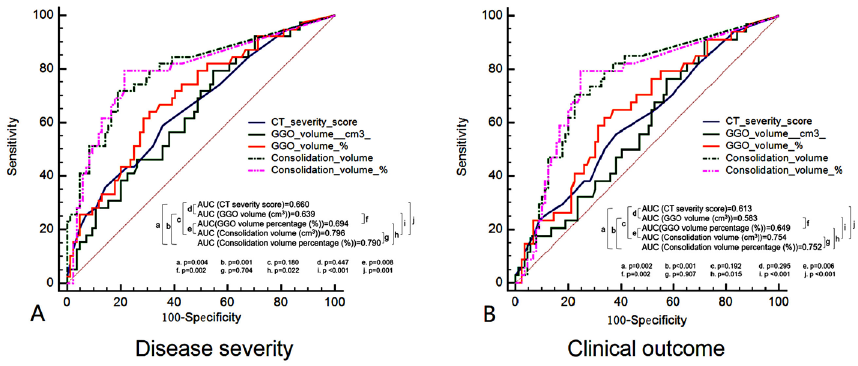
Figure 4. ROC curve analysis of CT-derived parameters for predicting disease severity progression ( A ) and clinical outcome ( B ). Disease severity progression was defined as the prediction of progress-to-severe group. Clinical outcome was defined as the prediction of occurrence of critical events (a. respiratory failure and need mechanical assistance; b. shock; c. “extra pulmonary” organ failure, d. ICU stay). AUC area under curve, CT computed tomography, GGO ground glass opacity, ICU intensive care unit, ROC receiver operating characteristic.